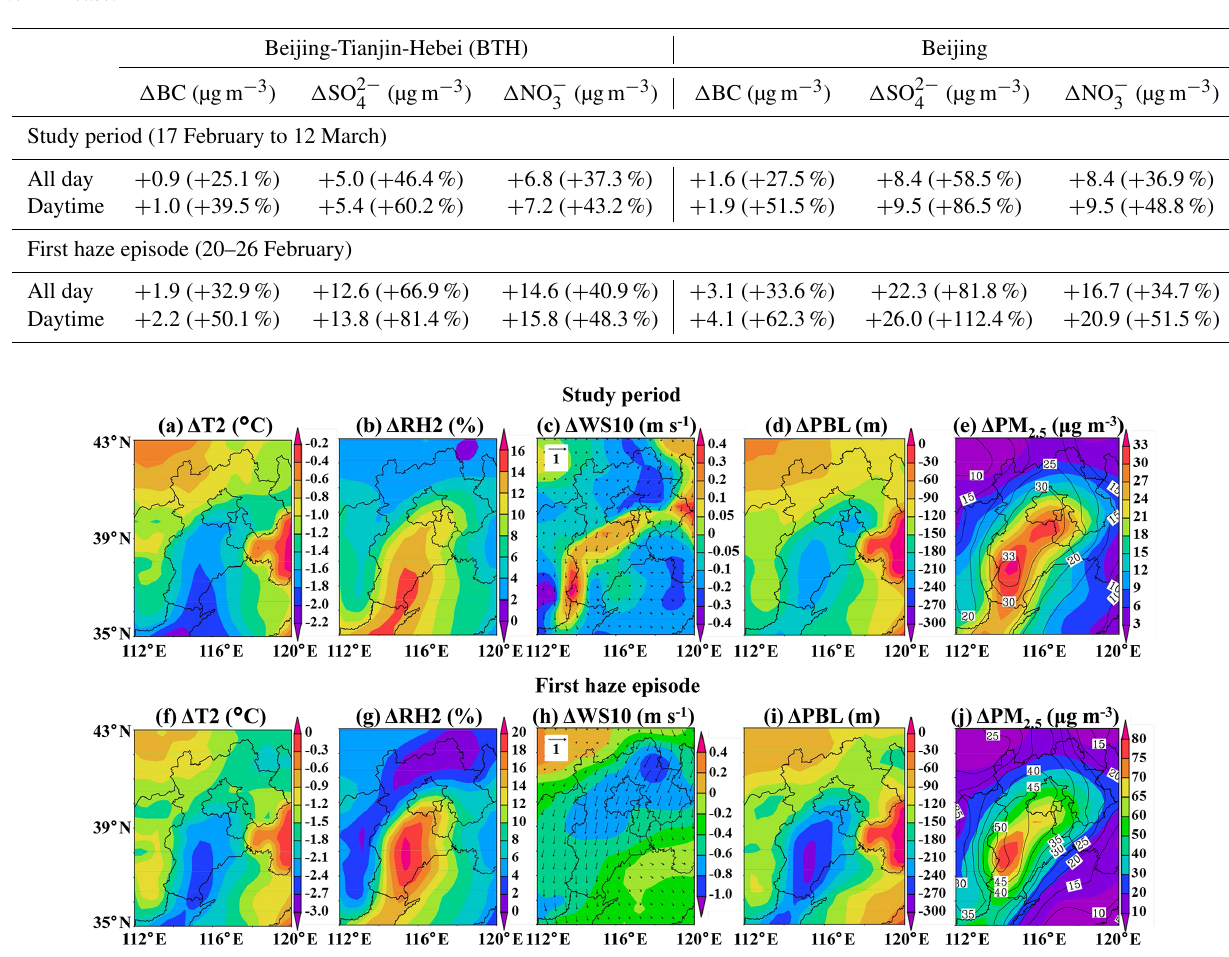
Figure 7. The model-simulated feedback-induced changes (FULL minus NoAFB) in (a, f) air temperature (T2), (b, g) relative humidity (RH2), (c, h) wind speed (WS10), (d, i) PBL height and (e, j) PM 2 . 5 concentration averaged over the entire study period (a–e) and over the first haze episode (20–26 February) (f–j) . Units are given in the